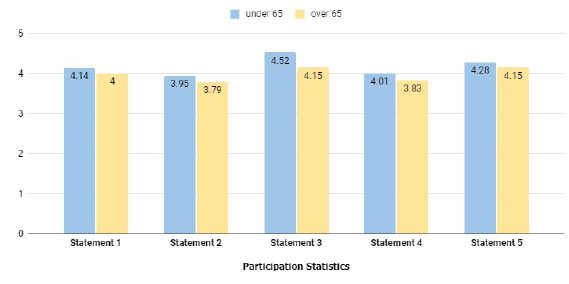
Figure 6. Comparison between age